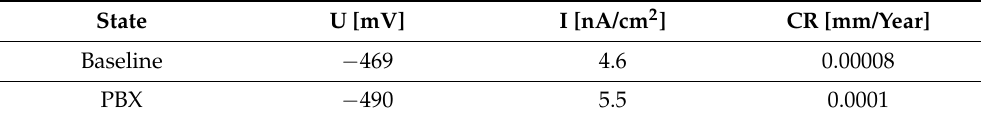
Table 5. Values of potentials and density of corrosion currents for the tested samples and the value of the corrosion rate given in